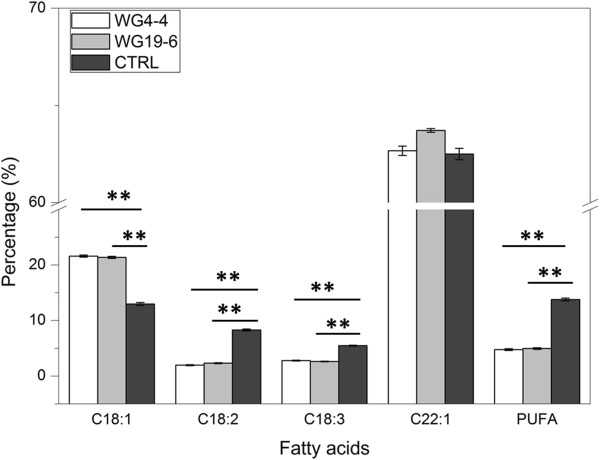
Comparison of the oil composition in the seeds of T2 family WG4-4, WG19-6 and control plants of C. abyssinica. The data represent the average of the two families and the control. For each plant, ten single seeds were measured. The bars indicate the comparisons with significant difference. **, P < 0.01. Error bar = standard error of mean.